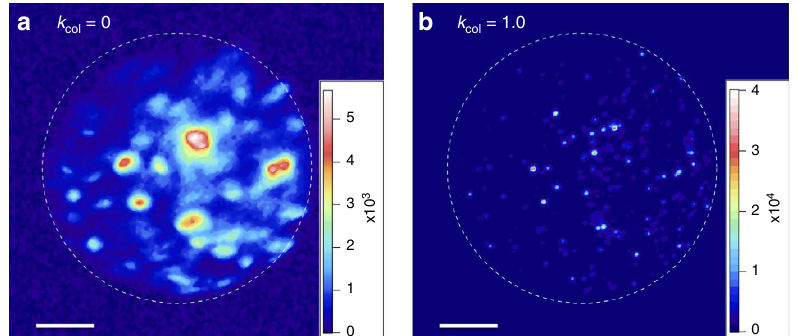
Figure 4 | Double-gate FEA beam images. ( a , b ) Beam image of the uncollimated ( k col ¼ 0) and collimated ( k col ¼ 1) condition, respectively, with V ge of 54V observed at L ¼ 0 and the cathode potential of (cid:2) 40kV under the cathode imaging condition (solenoid current ¼ 0.75A). The scale bars indicate 1mm on the phosphor screen. The field emission beamlets are finely visualized for the collimated beam ( k col ¼ 1). The broken circle shows the envelope of the beamlet that corresponds to the physical boundary of the array, equal to 1.13mm diameter on the chip.